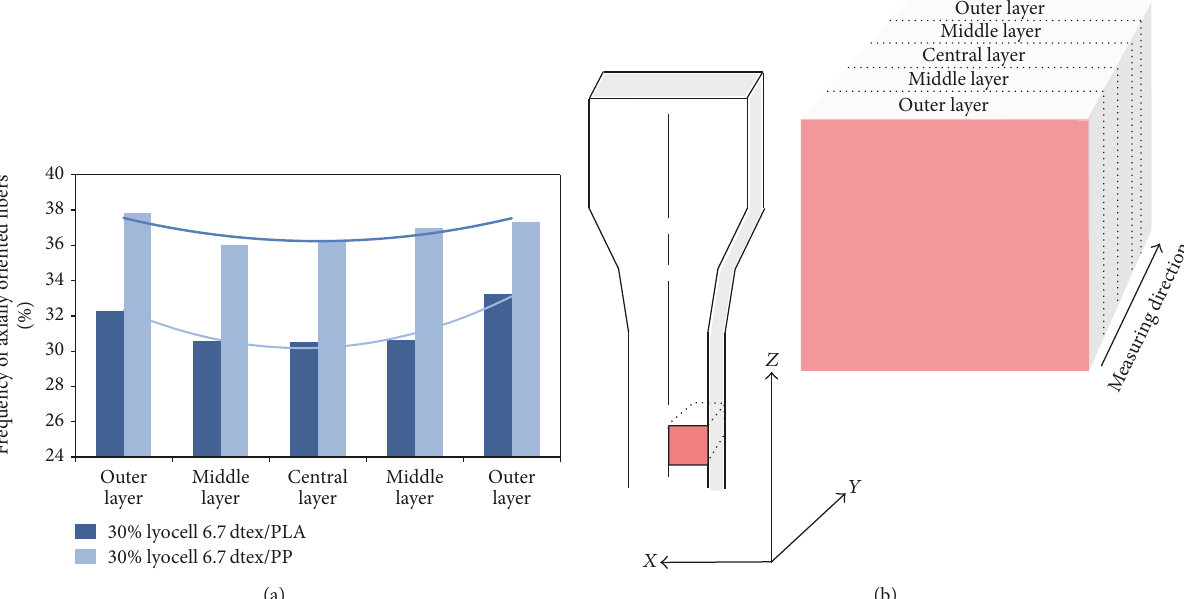
Figure 2: (a) Frequency of axially oriented fibers (0–10 ∘ ) measured across a tensile test specimen of an IM PLA and IM PP composite (note interrupted y -axis). (b) Schematic of the measuring direction across sample height in the parallel section of a test specimen.